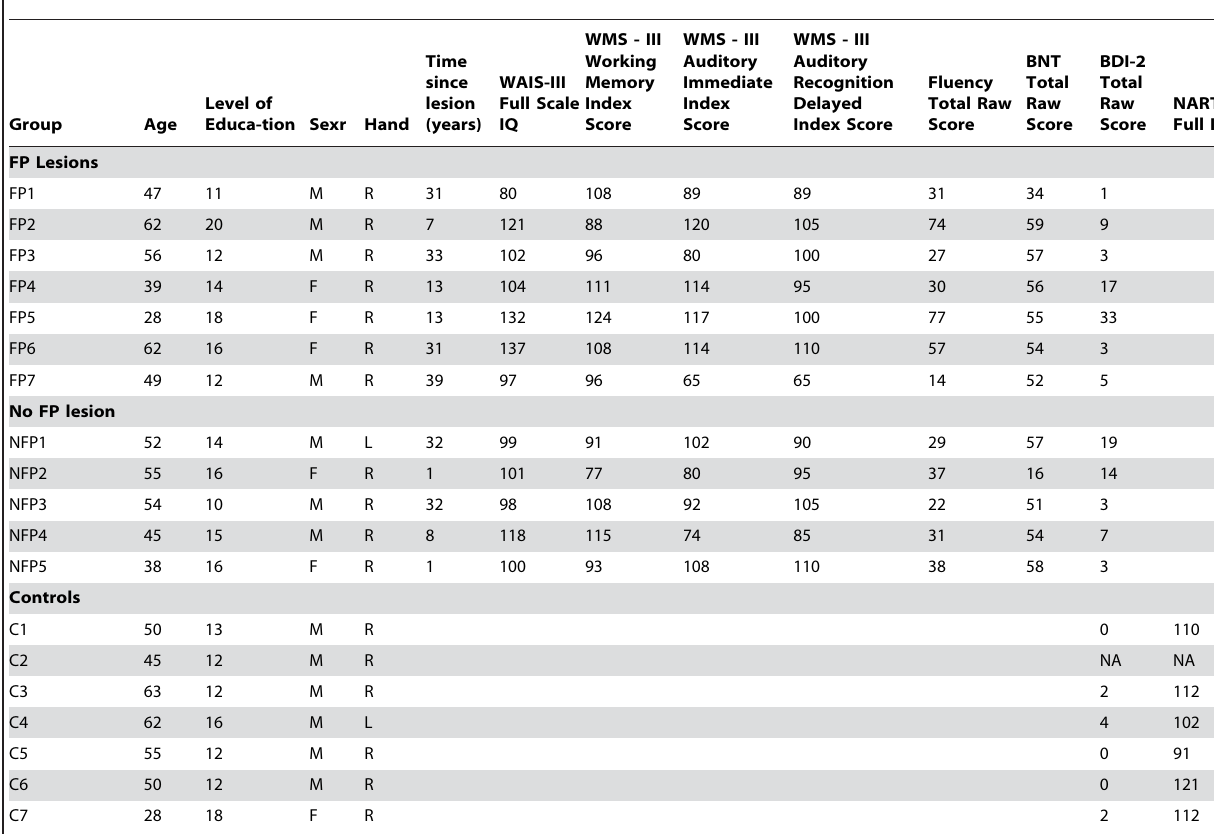
Table 1. Demographic of patients and healthy control subjects.